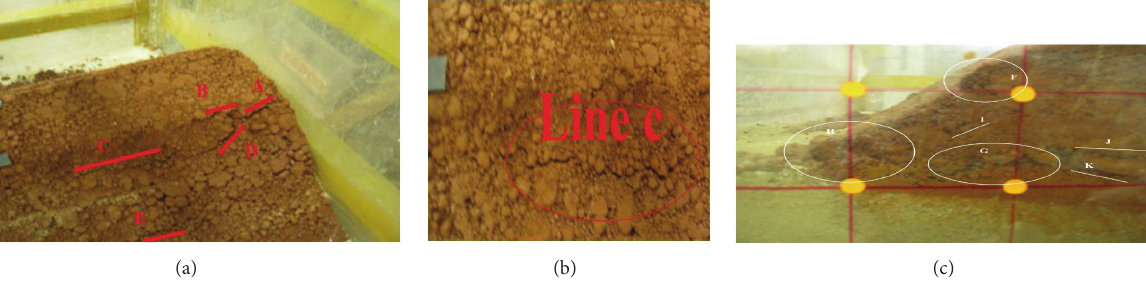
Figure 20: Damage in the first model (Model A).